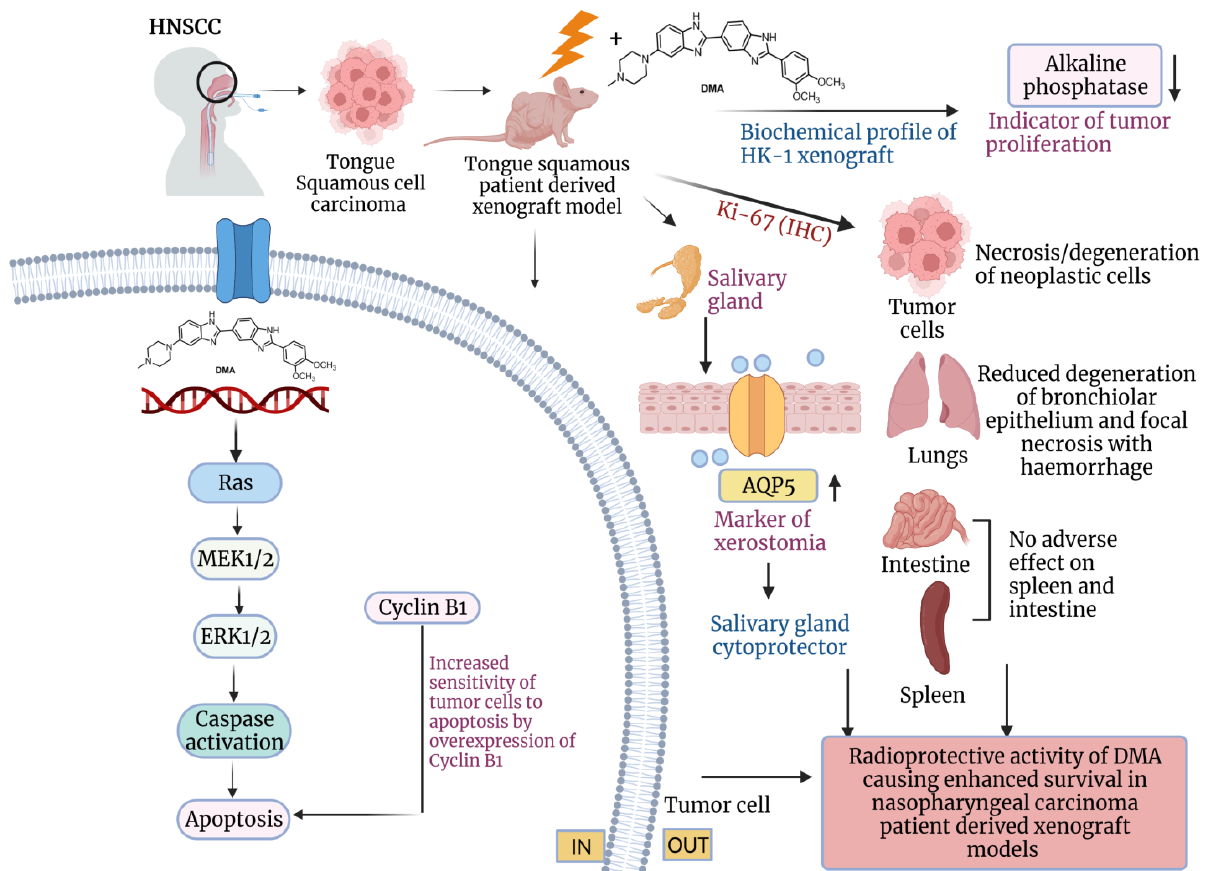
Figure 9. Schematic representation of the radioprotection of normal cells and tumor ablation by DMA in xenograft mouse model. The proposed model shows that DMA with irradiation activates the RAS/MEK pathway, leading to increased apoptosis in PDX tumor tissues. Further, the reduced levels of alkaline phosphatase, restoration of aquaporin water channels on salivary glands, and reduced Ki-67 levels in tumor cells, as well as normal tissues, contribute to the radioprotective potential of DMA in normal cells, which leads to enhanced survival in PDX models.